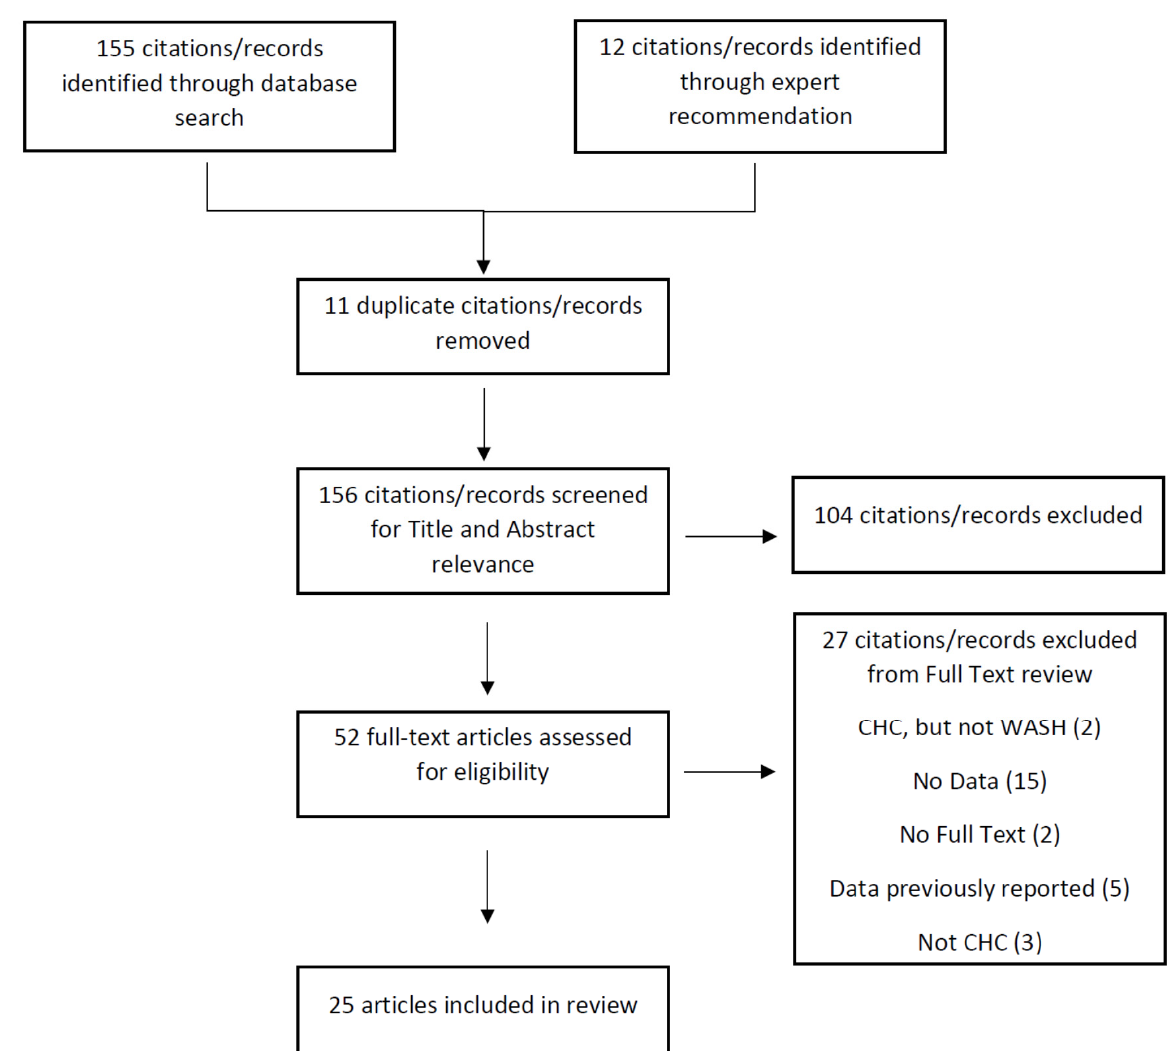
Figure 1. PRISMA Diagram. Note: WASH refers to Water, Sanitation and Hygiene and CHC refers to Community Health Clubs.